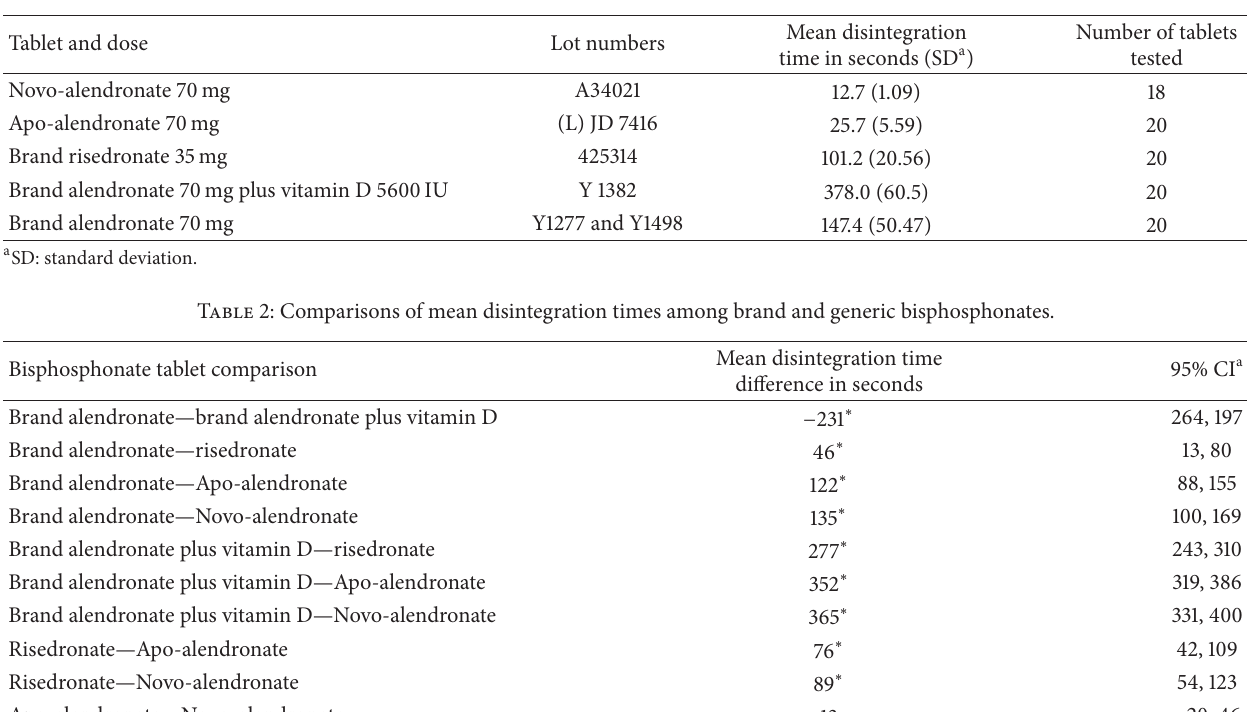
Table 1: Amino-bisphosphonate tablet group sample size, lot numbers, and disintegration times.